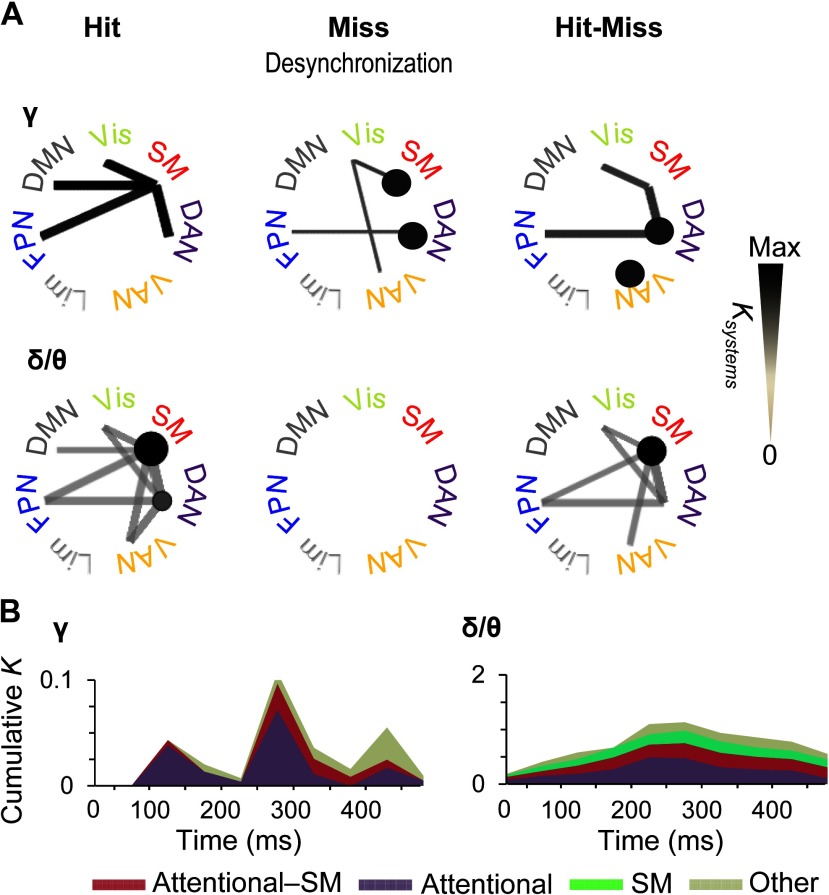
Time-varying subsystem connectivity within and between attentional systems and SM. (A) Connection densities of significant interareal gamma-band (40–60) Hz and delta/theta-band (3–7 Hz) synchronization among Yeo-atlas brain systems for Hits and Misses compared with baseline and for their difference. Only such system-system connections are shown that exhibit greater connection densities than expected by chance in shuffled graphs (p < 0.05, permutation statistics, see Methods). The color, line width, and radius of circles of the system-system connections indicates the connection density of significant couplings (Ksystems) within (circles) or between (lines) the functional systems in a time window of 225–375 ms. (B) Time-resolved cumulative connection densities (K) of gamma- and delta/theta-band synchronization estimated separately for within-attentional (DAN, FNP, and VAN), between SM and attentional, and all other functional subsystems. Synchronization in task-positive sensory and attentional systems predicted subsequent conscious perception in gamma band, whereas synchronization in the delta/theta band was observed in SM along with connections to and within-attentional systems throughout the time course of stimulus detection.